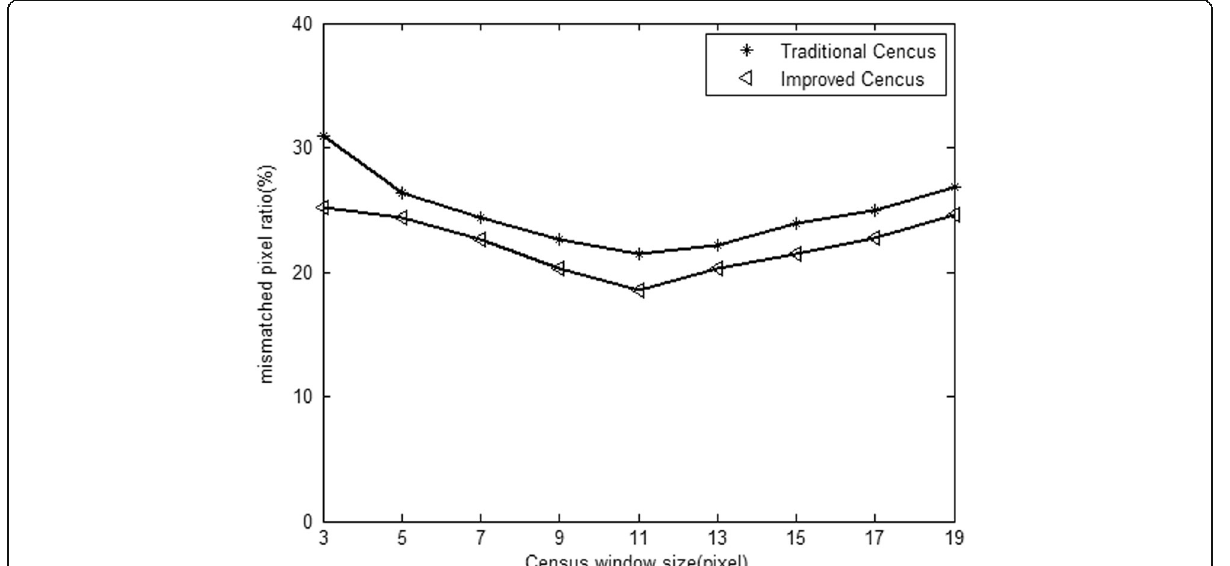
Fig. 5 Influence of different Census transform window sizes on matching quality